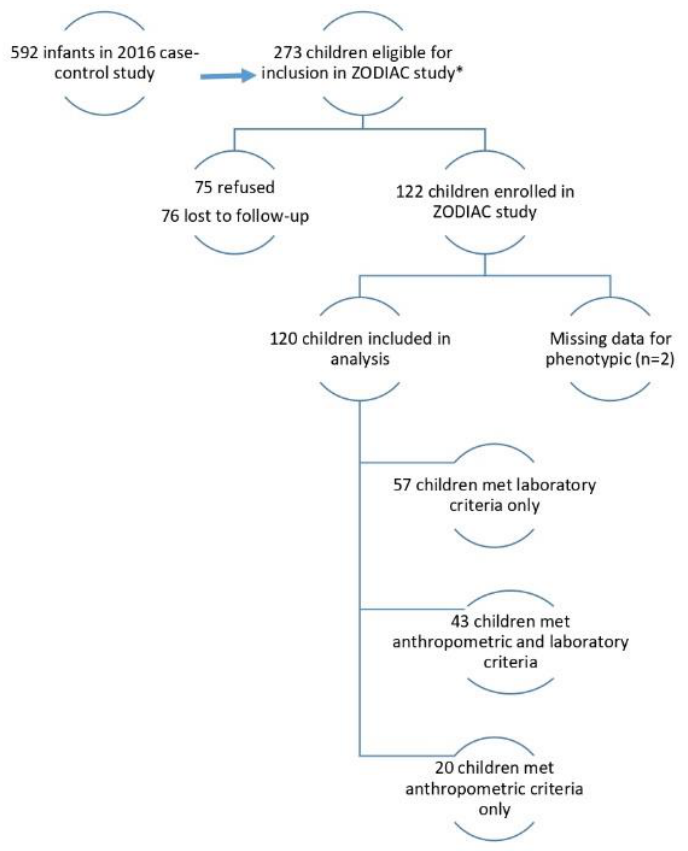
Figure 1. Eligibility for the Zika Outcomes and Development in Infants and Children (ZODIAC) Investigation, Paraíba, Brazil, 2017. Anthropometric criteria: head circumference (HC) ≤3rd percentile for gestational age and sex or HC > 3rd percentile for gestational age and sex and HC-to-body length ratio ≤ 0.65; Laboratory criteria: non-negative test results for Zika-specific neutralizing antibodies in an infant sample.